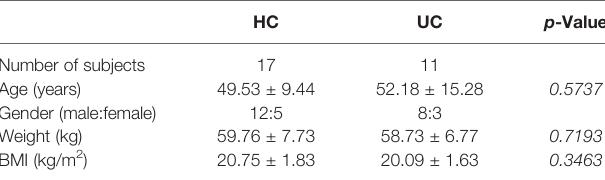
TABLE 1 | Demographic of patients with UCs and